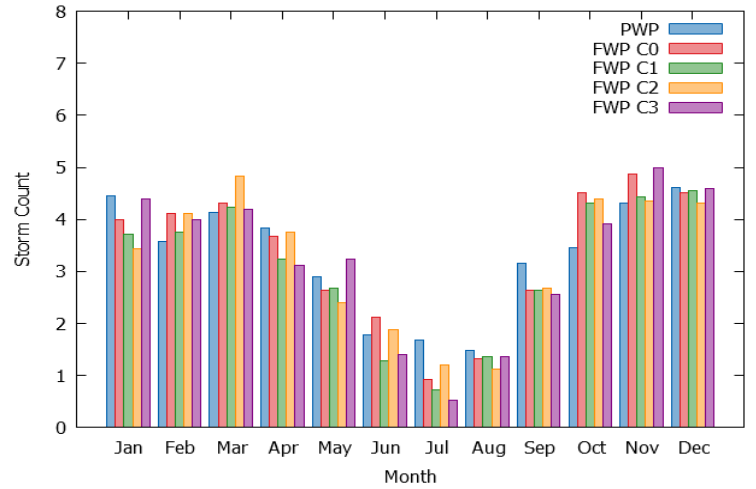
Figure 9. Comparison of present (PWP) and future (FWP-C0–C3) storm count at Pembroke.